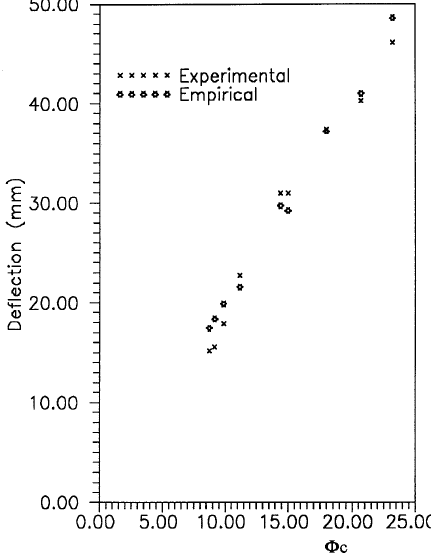
Fig. 13. A comparison of empirical prediction with experimental data for plastic deformation.